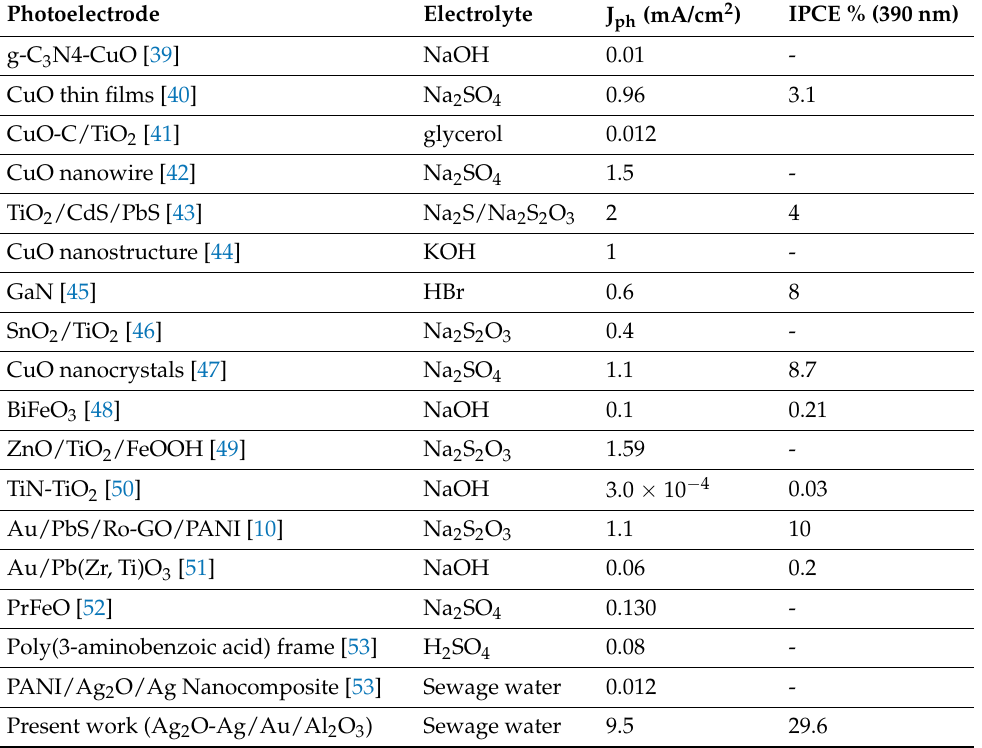
Table 1. Comparison of the present study with previous literature through the used electrolyte, current density, and